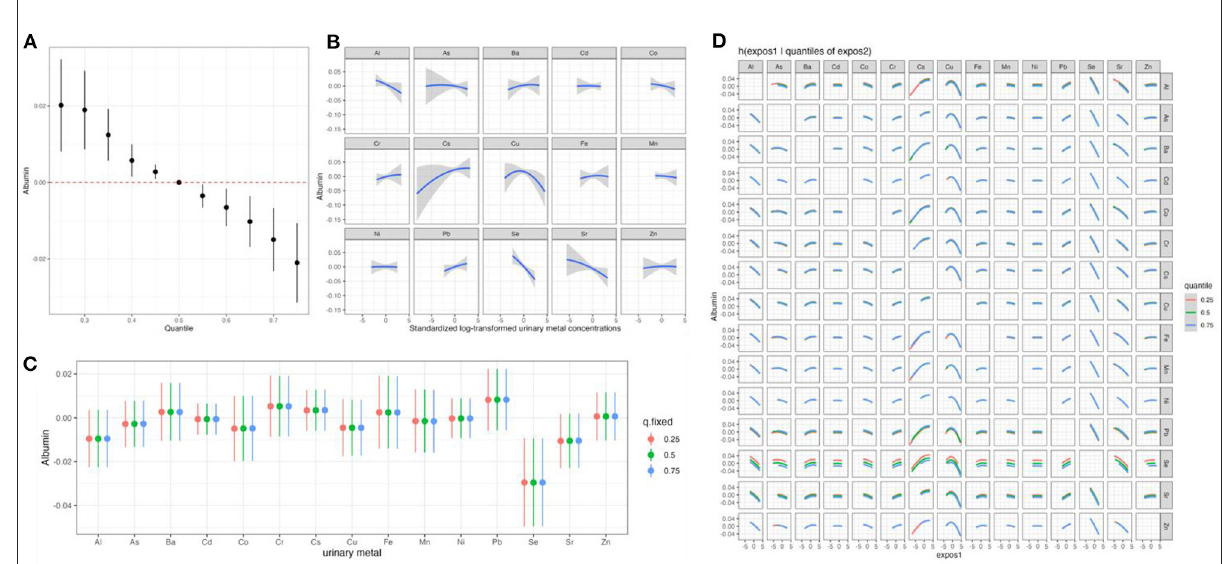
FIGURE2 The effects of the element mixtures on serum albumin estimated by Bayesian Kernel Machine Regression. Model adjusted for age, sex, BMI, educational attainment, cigarette smoking habits, alcohol consumption habits, hypertension status, and diabetes status. (A) Overall effect of the element mixtures; (B) univariate exposure–response relationships; (C) the single exposure-response functions for each element; and (D) bivariate exposure–response functions for pairs of elements. Al, aluminum; As, arsenic; Ba, barium; Cd, cadmium; Co, cobalt; Cr, chromium; Cs, cesium; Cu, copper; Fe, iron; Mn, manganese; Ni, nickel; Pb, lead; Se, selenium; Sr, strontium; Zn, zinc; BMI, body mass